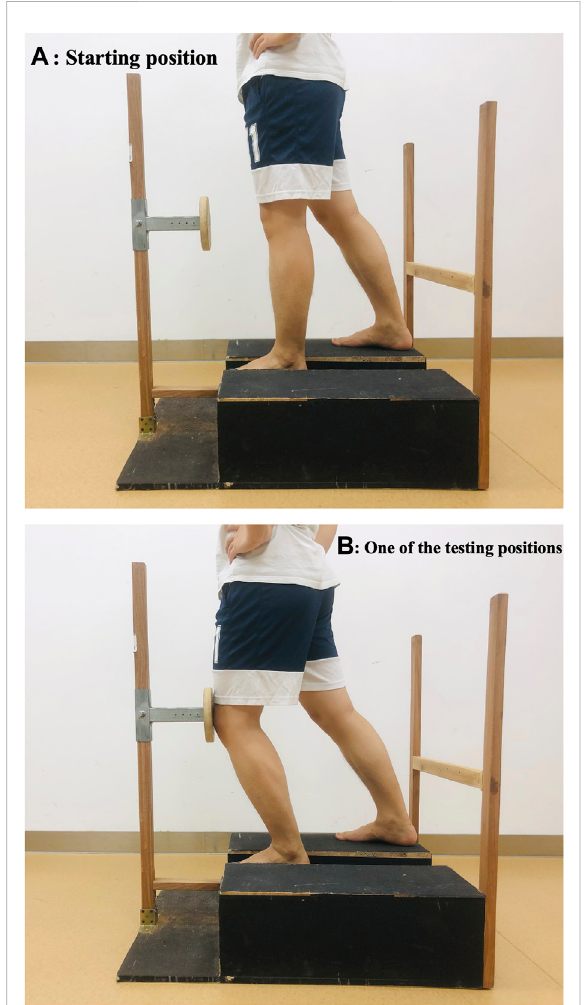
FIGURE 2 Knee proprioception assessed by the knee AMEDA. (A) Starting position: participants were instructed to look forward and perform a lunge squat from a standardized start position. (B) One of the testing positions: participants were instructed to make an absolute determination of knee lunge extent when their patella touched the wooden disc, using numbers 1,2,3 or